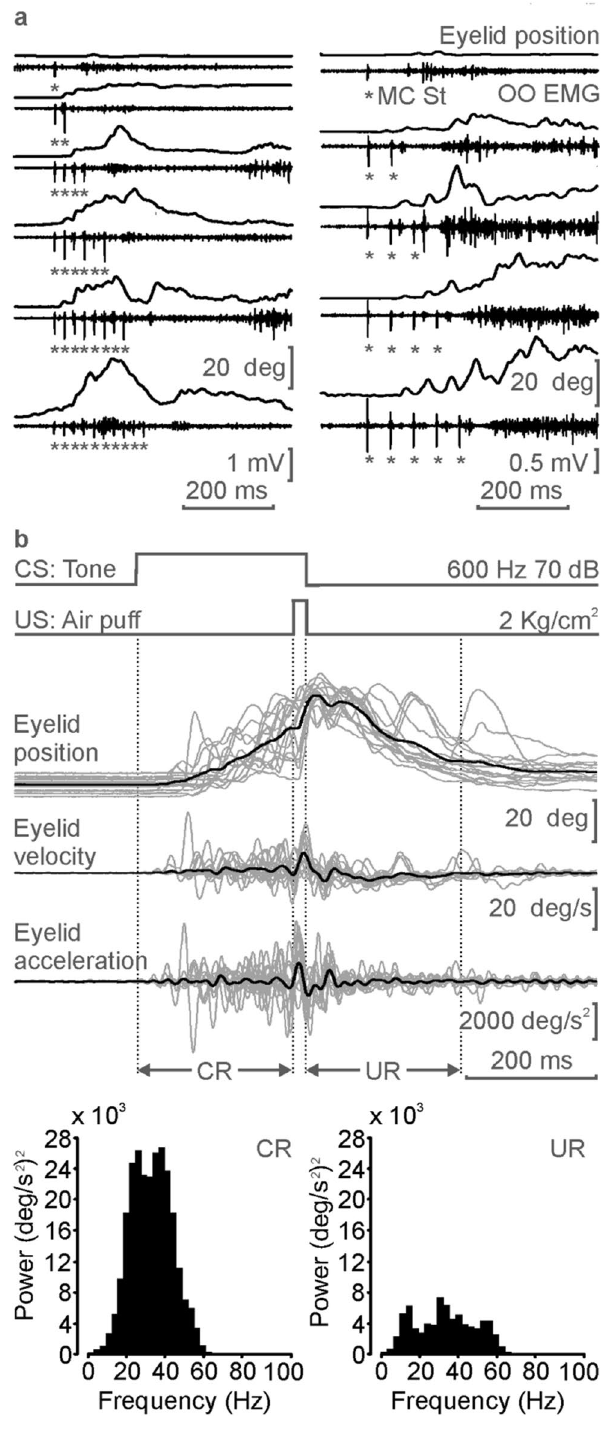
Figure 4. Effects of the electrical stimulation of the MC, and spectral powers of the evoked eyelid responses in conditioned mice. ( a ) Effects of the electrical stimulation of the contralateral MC on the EMG activity of the OO muscle, and on the corresponding eyelid position. The MC was stimulated with an increasing number of paired pulses (1-ms interval) at frequencies of 40 (left) and 20 (right) Hz. Each recording corresponds to an average of n ≥ 6 trials. Note the delayed response with respect to the beginning of the train stimulus, more evident with the 20 Hz pulses. ( b ) Spectral power collected from lower eyelid responses recorded with the magnetic recording technique. An average of 15 trials collected from the first conditioning session, using a delay paradigm, was differentiated once to obtain eyelid velocity and a second time for eyelid acceleration. The spectral power of CRs (bottom, left) and URs (bottom right) showed a maximum peak at frequencies ranging from 30 to 40 Hz. The 20-ms time interval between CR and UR, corresponding to the air-puff stimulation, was excluded from the study to avoid spectral artifacts due to passive eyelid movements evoked by the air